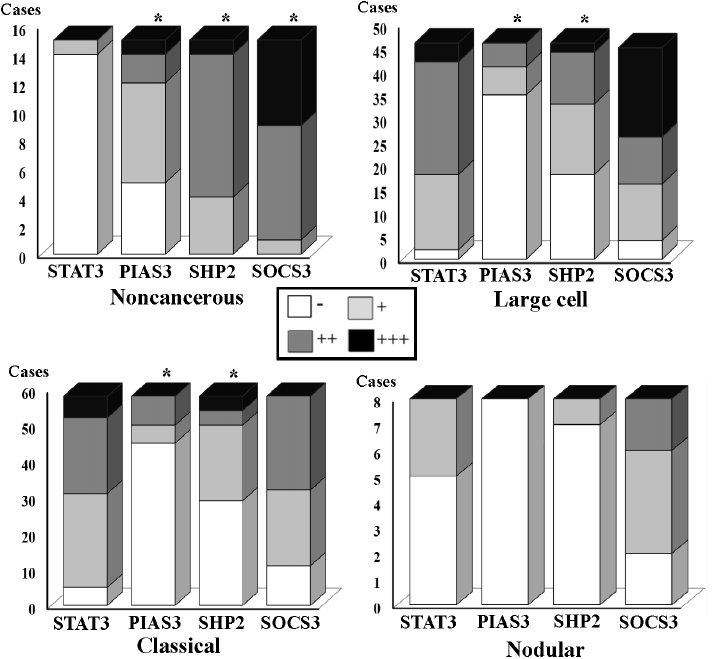
Figure 3. Fractionation of STAT3 nuclear translocation and SHP2, SOCS3 and PIAS3 expression levels in the tumor ‐ surrounding noncancerous brain tissues (Upper left) and the large ‐ cell (Upper right), classical (Low left) and nodular medulloblastomas (Low right). * Statistical analyses show significant reduction of their detection rates in comparison with that of the tumor ‐ surrounding brain tissues ( p = 0.000).